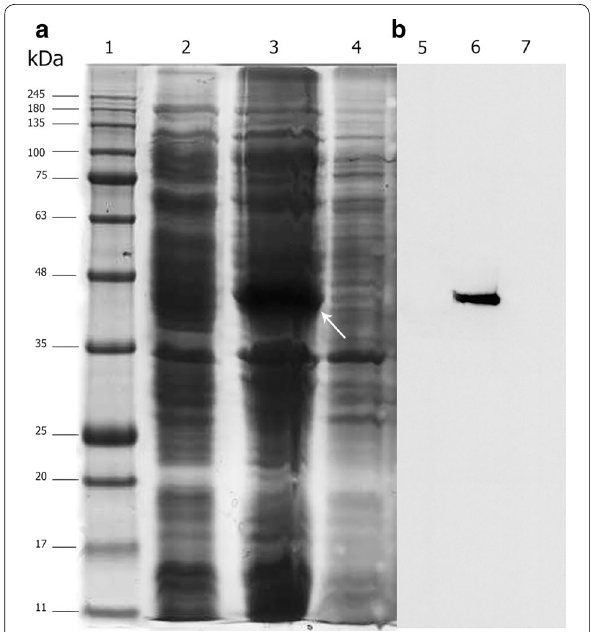
Fig. 2 The expression analysis of anti-CD22 scFv–apoptin in the soluble and insoluble fractions of lysed bacterial cells. a SDS-PAGE analysis: protein molecular weight standards ( lane 1 ), total protein from E. coli BL2 (DE3) containing pET-28 a ( ) vector (negative con- + trol) grown under identical condition ( lane 2 ), insoluble fraction ( lane 3 ), and supernatant of cell lysate ( lane 4 ) of induced E. coli BL2 (DE3) containing pET-anti-CD22 scFv–apoptin. A major band of ~44 kDa in insoluble fraction indicates anti-CD22 scFv–apoptin ( white arrow ). b Western blot analysis: the samples were loaded as in